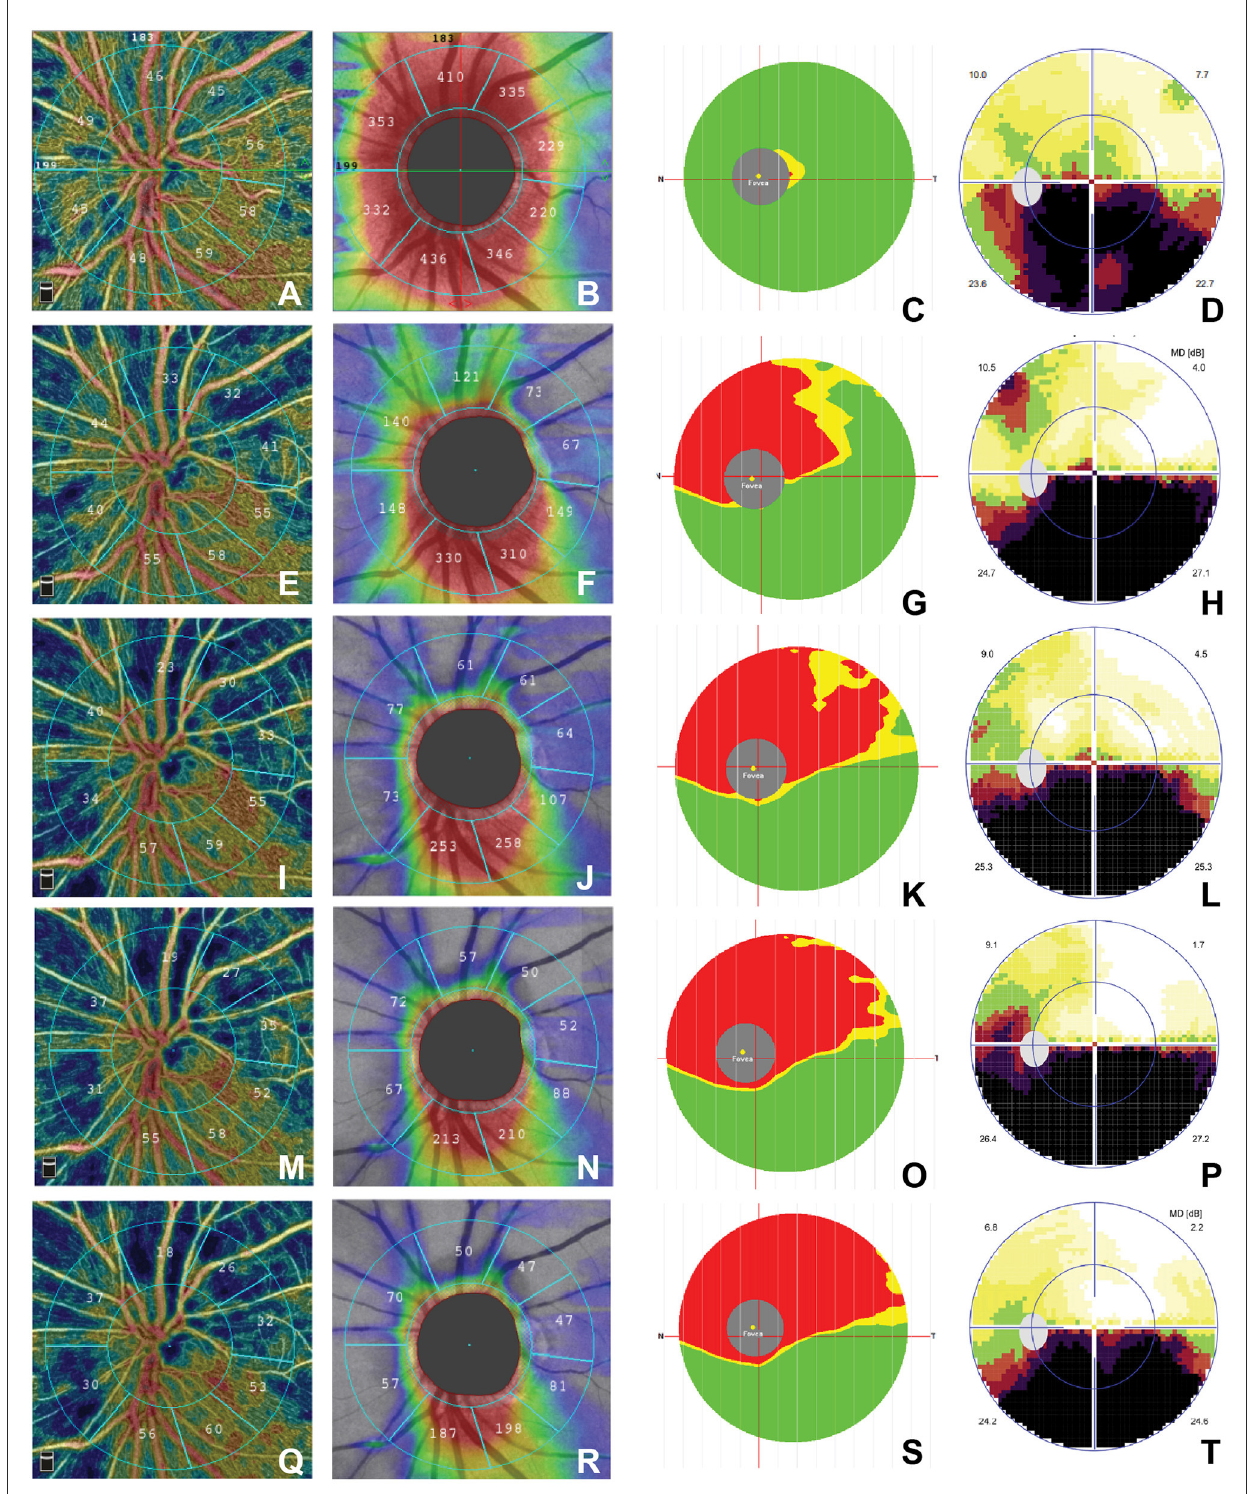
FIGURE1 Time course of structural OCT and OCTA findings in a 52-year-old female patient. (a) ≤ 3 week: (A–D) ; (b) 3–8 weeks: (E–H) ; (c) 9–12 weeks: (I–L) ; (d) 12–24 weeks: (M–P) ; (e) > 24 weeks: (Q–T) . The RPC map shows sector atrophy from the acute stage to the chronic stage (A, E, I, M, Q) , the pRNFL map shows decreased thickness over time (B, F, J, N, R) , and the mGCC map shows the reduction of superior-hemi mGCC over time (C, G, K, O, S) . The visual field map shows inferior arc-shaped defects that did not change significantly for better or worse (D, H, L, P, T) . OCTA,